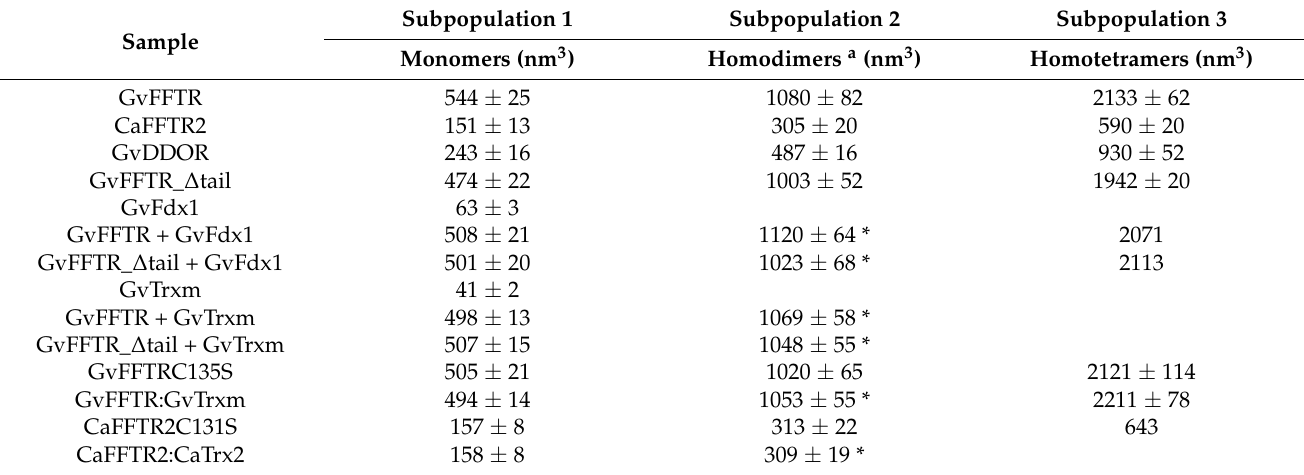
Table A2. Estimated relative volumes (mean ± SD) for the features corresponding to the different protein samples analyzed in this work. Samples were measured in PBS pH 7.0, except for GvFdx1 and GvTrxm, which were analyzed at PBS pH 6.0. * Volume values showing statistically significant differences from the corresponding free GvFFTR, GvFFTR_ ∆ tail, or CaFFTR2 homodimers, as determined by the Student’s test ( p < 0.05).